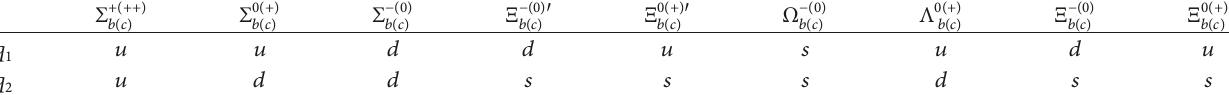
Table 1: The quark flavors 𝑞 1 and 𝑞 2 for the baryons in the sextet and the antitriplet